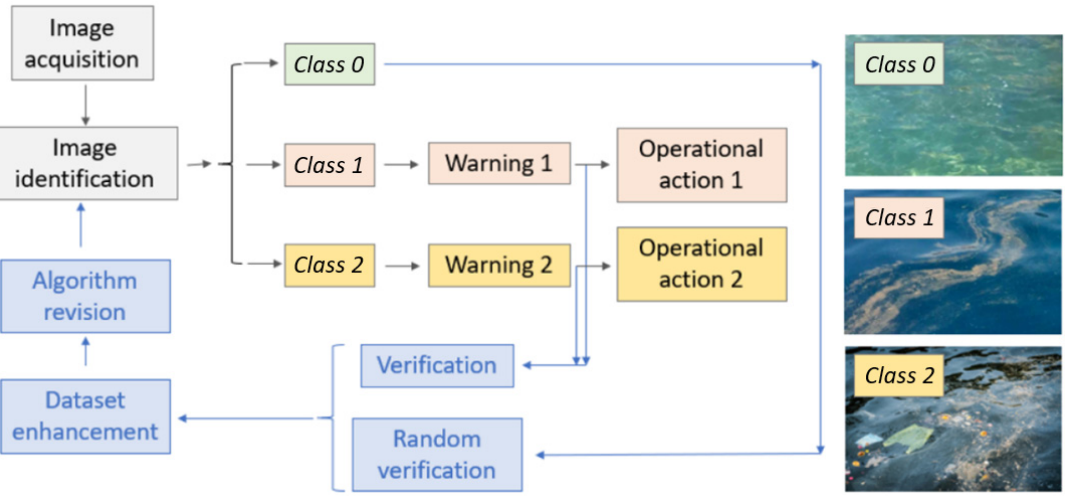
Figure 8. Progressive implementation of port water monitoring systems. The operational action refers to eventual anti-pollution measures planned by the port authority.